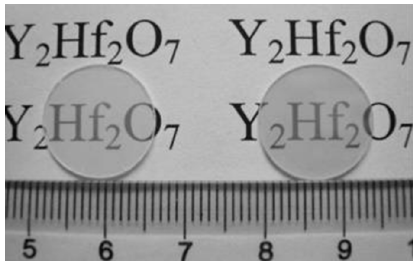
Fig. 7 Photograph of the mirror-polished Y 2 Hf 2 O 7 transparent ceramics (1 mm thick) sintered at 1900 ℃ for 6 h (left) and 12 h (right), respectively. Reproduced with permission from Ref. [87], © Elsevier B.V. 2012.